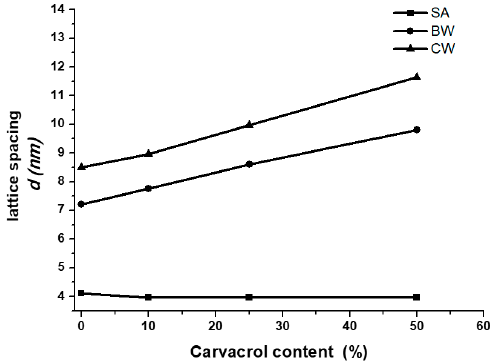
Figure 5. Value of lattice spacing “ d ” measured by small-angle X-ray scattering of bulk solid lipids (stearic acid, beeswax and carnauba wax) plotted as a function of carvacrol concentration (10%, 25% and 50%).